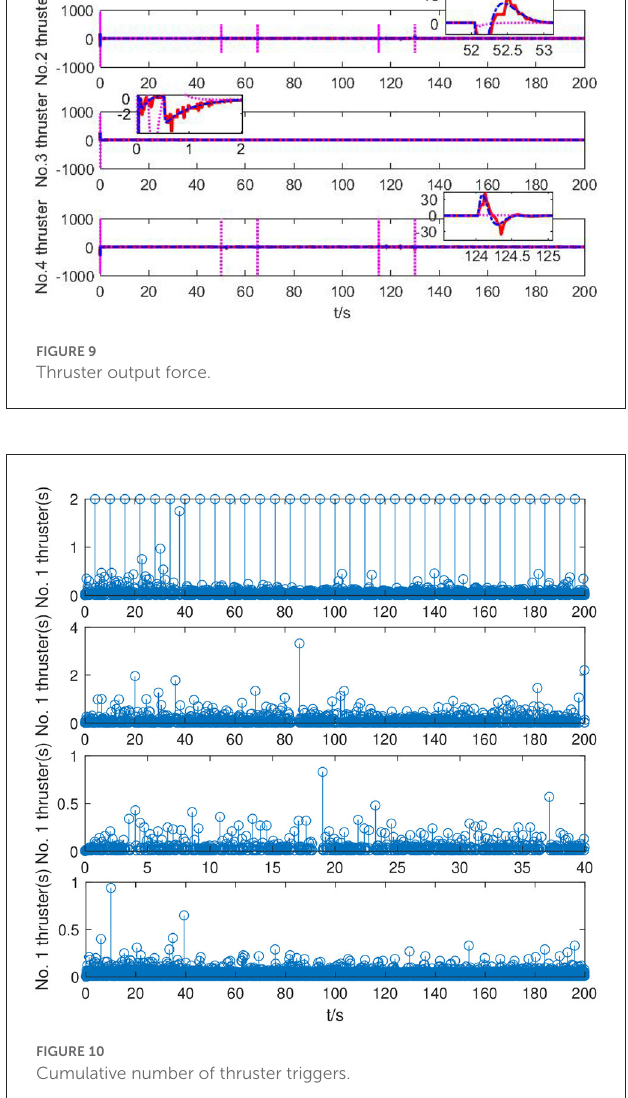
FIGURE10 Cumulative number of thruster